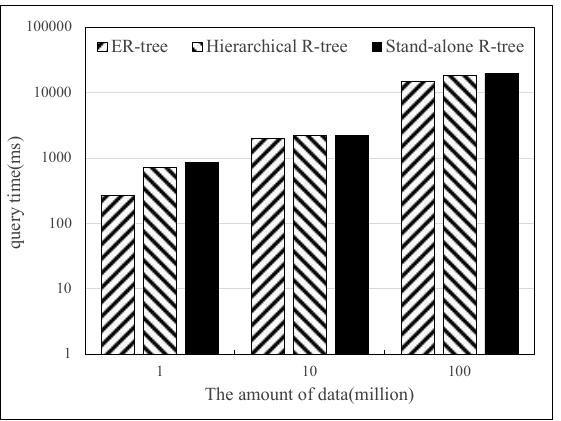
Figure 12. Comparison of the index point query performance on the simulated datasets. Simulated dataset range query: For each database with different amounts of data after building the index, this paper performed 1000 random range queries with various range lengths and calculated the average query time to compare the query performance of the index. The experimental results are shown in Figure 13. The vertical coordinate is the logarithmic axis. The results show that the ER-tree index has better range query performance than the other two, for the same reason as the point query.